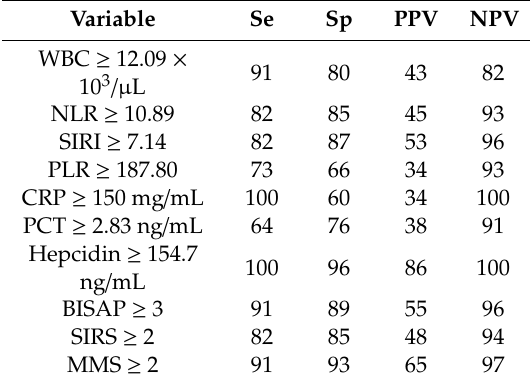
Table 5. Prognostic accuracy of the biochemical markers and the score systems of acute biliary pancreatitis severity at 48 h. Variable Se Sp PPV